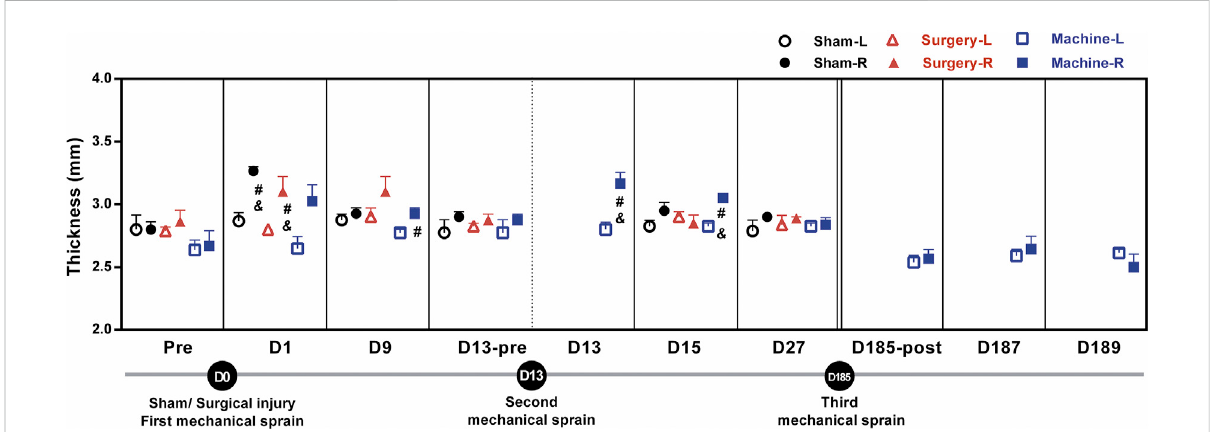
FIGURE 3 Changes in ankle thickness after mechanical ankle sprains. The level of ankle swelling was measured using a thickness gauge on the indicated day after sham operation or CFL transection or three times of mechanical ankle sprains. The statistical signi fi cance was analyzed using paired t test, # p < 0.05 compared with corresponding left untreated foot (L) and & p < 0.05 compared with the corresponding right foot (R) of pretreatment (pre) baseline or before the second mechanical sprain (D13-pre) on the 13th day